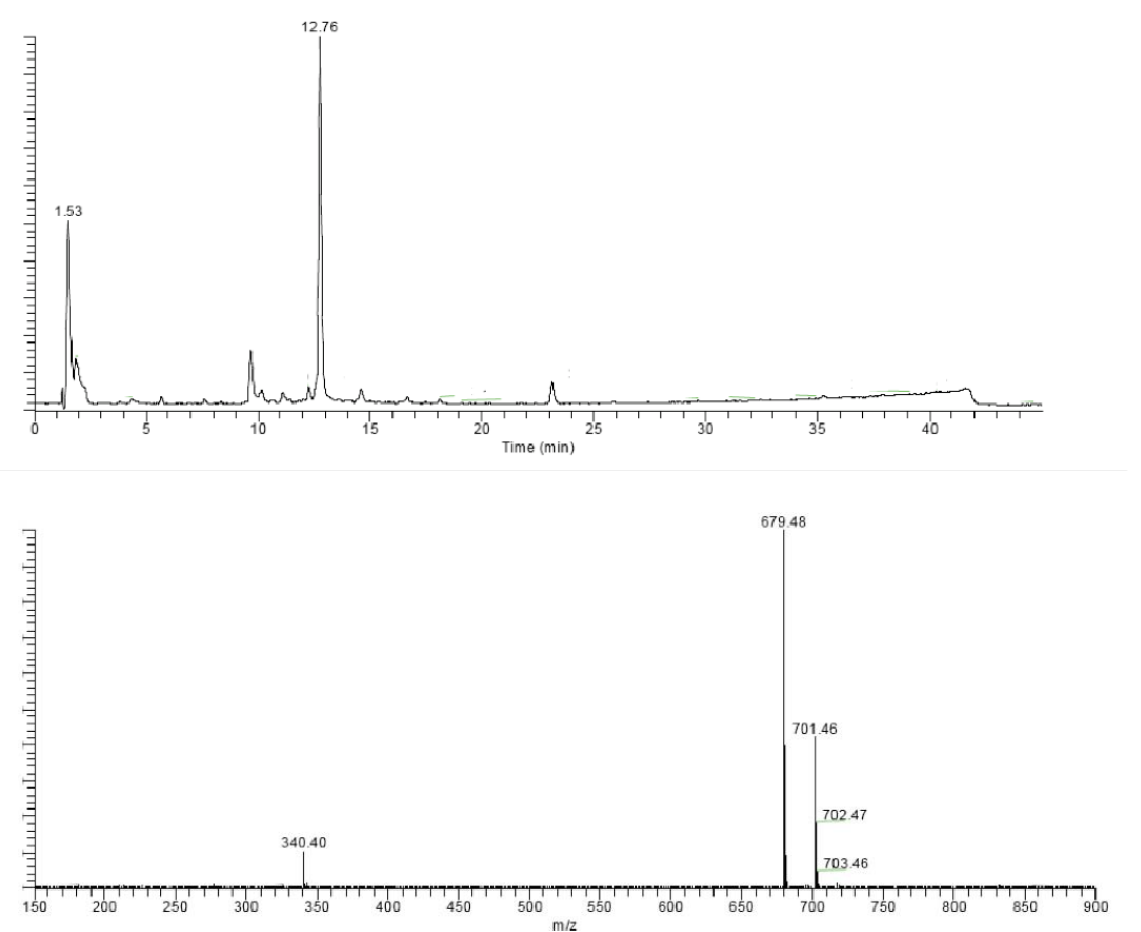
Figure 4. LC-MS results for the peptide cleavage after Eu treatment of the